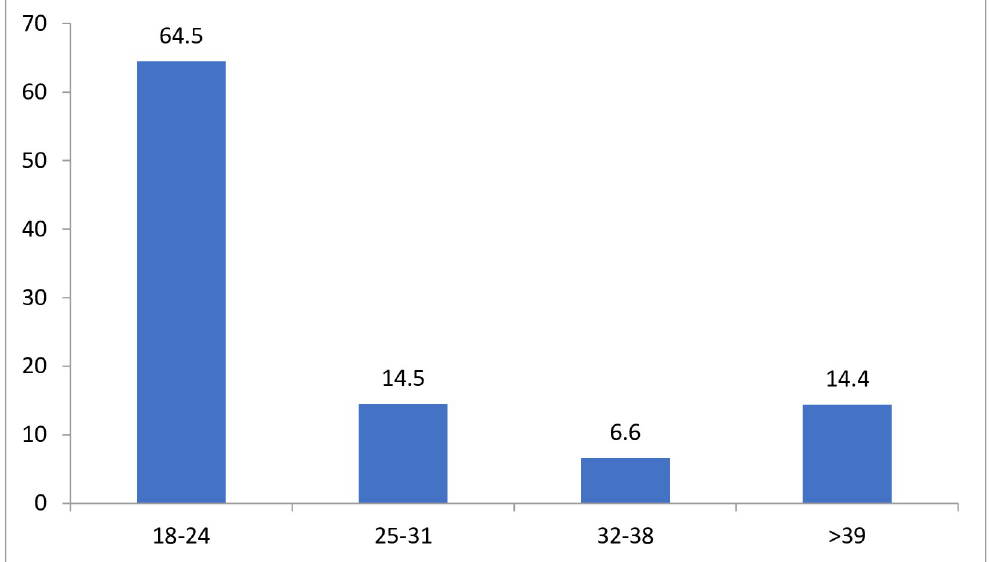
Fig 2. Graphical representation of magnitude of depression in by age group 2019, Wollega, Ethiopia.